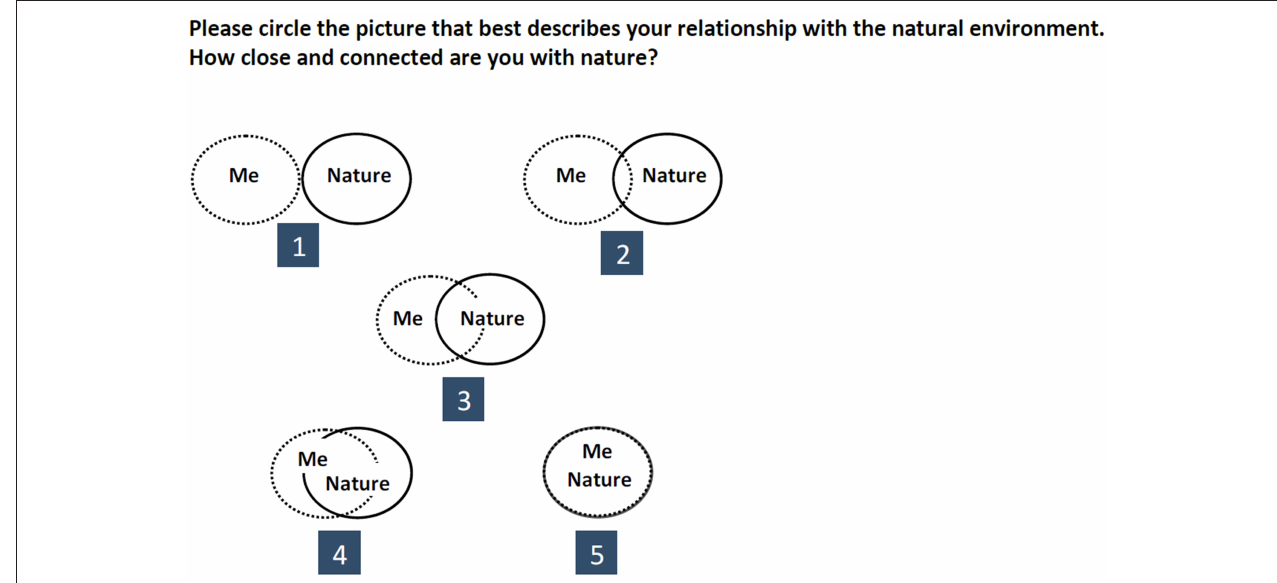
FIGURE 1 | Single item used to measure youth connection with nature, adapted from the Inclusion of Nature in Self (INS) scale developed by Schultz